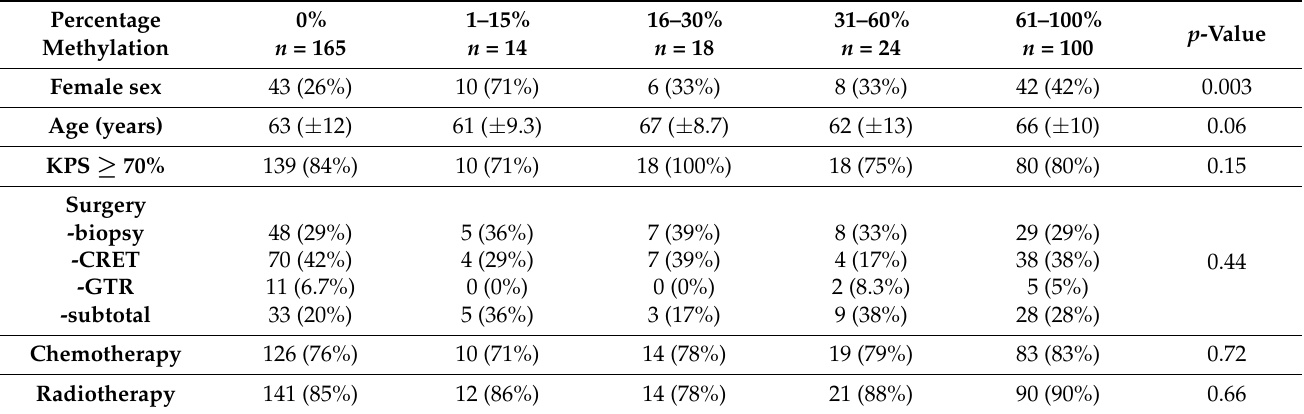
Table 1. Comparison of baseline variables by MGMT methylation group.